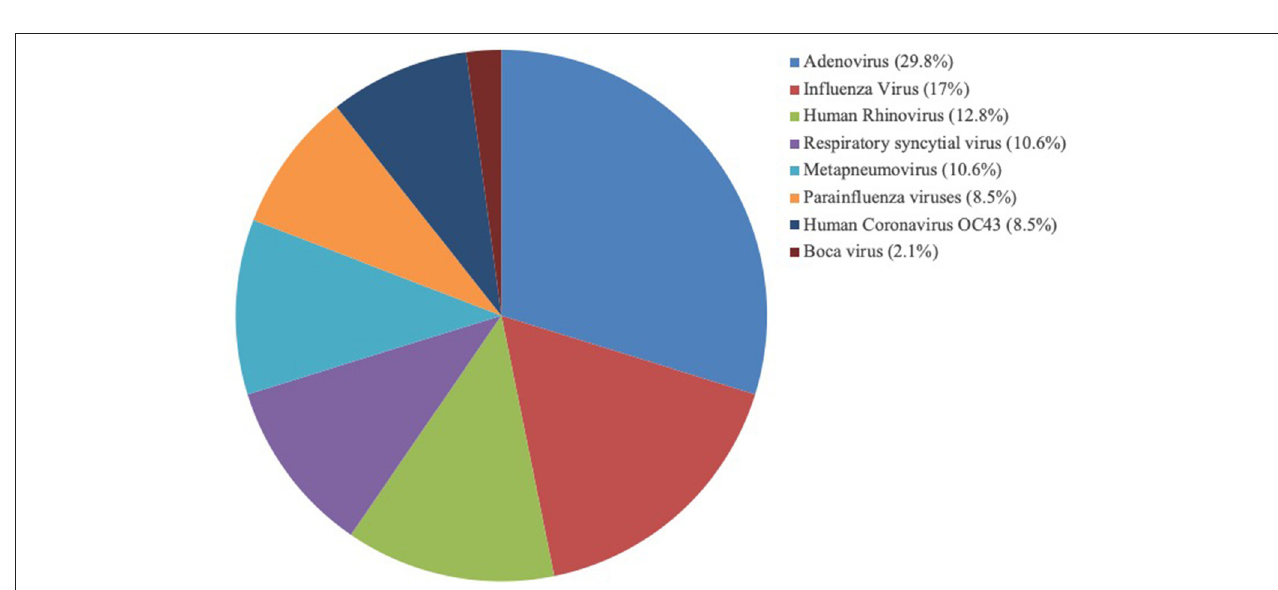
FIGURE 1 | Flowchart of patient groups in the study. ARDS, acute respiratory distress syndrome.